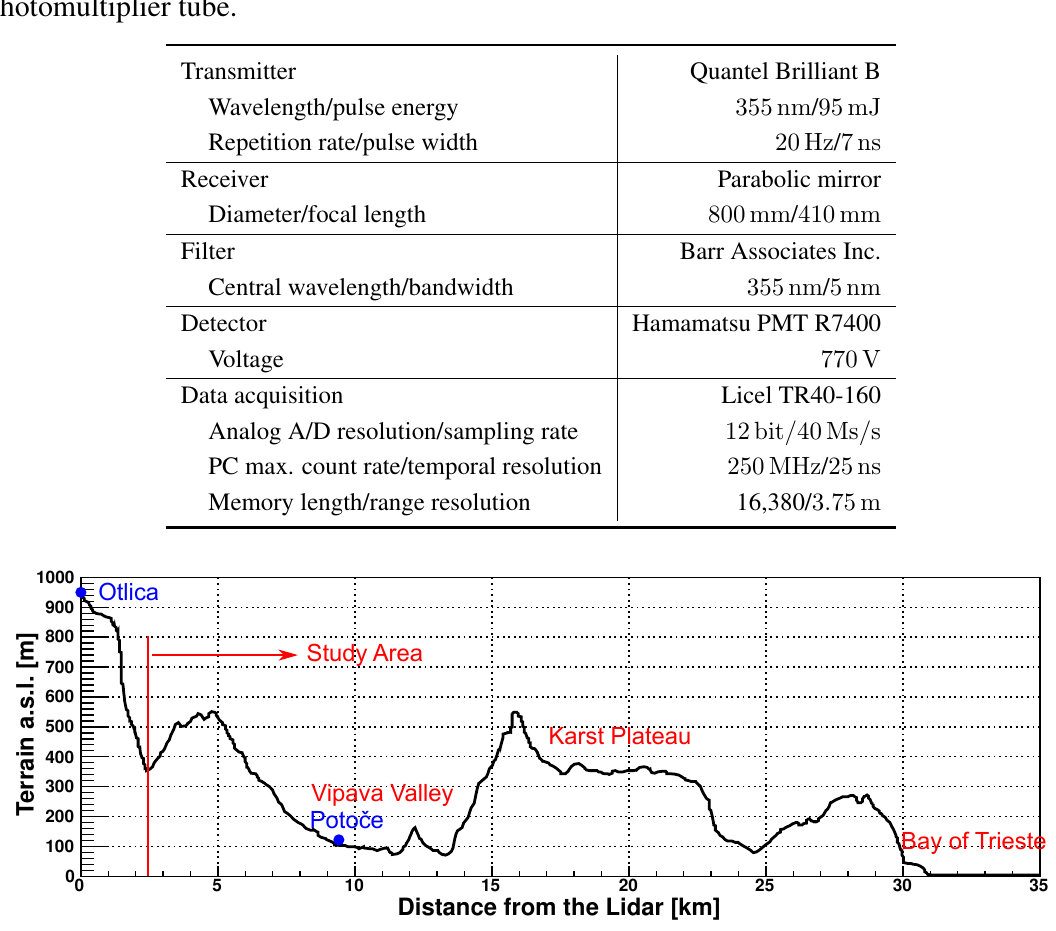
Figure 2. Terrain configuration along the LiDAR scanning line. The study area is marked by the red arrow, including the Vipava Valley, the Karst Plateau and the Bay of Trieste. In order to see the variation of the terrain configuration in the study area, the vertical axis is scaled in meters, while the horizontal axis of the distance from the LiDAR is scaled in